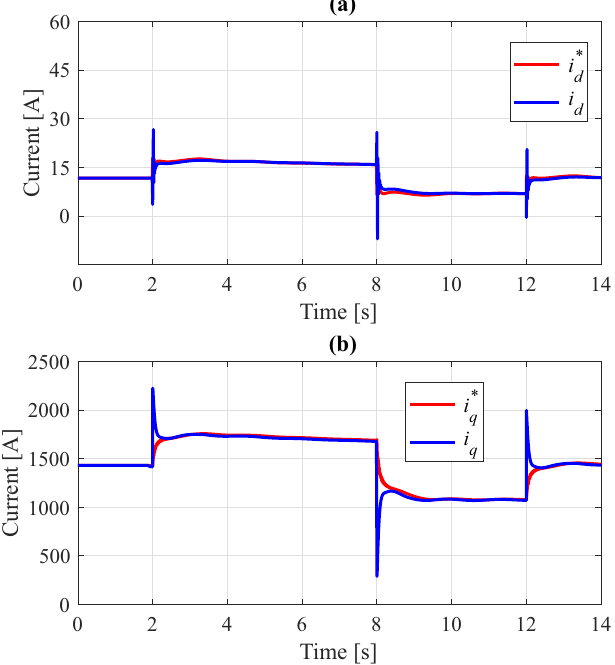
Figure 7. Currents of the data-driven controller during changes in the AC reference voltage: ( a ) d -axis current and ( b ) q -axis current.